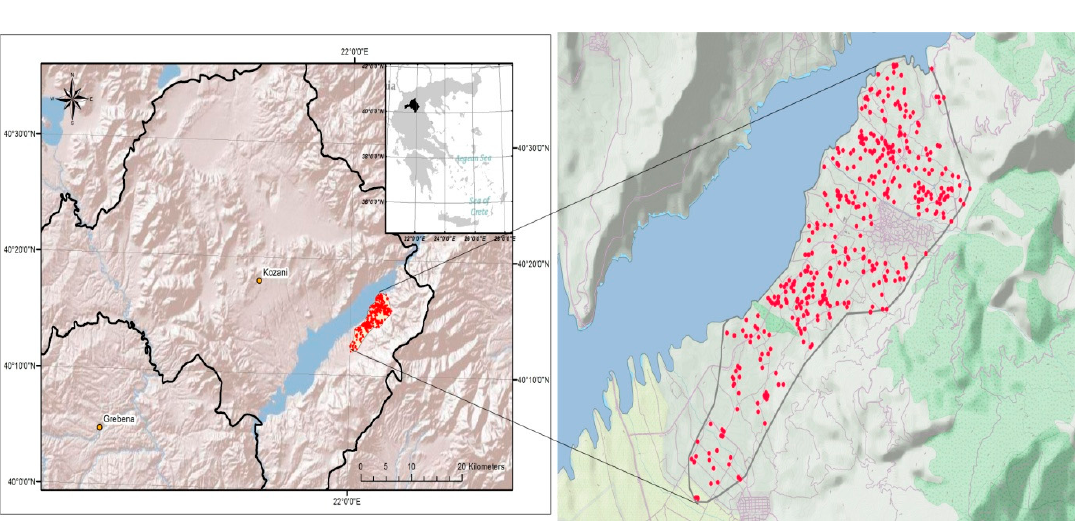
Figure 1. The 400 survey points in the Kozani area around Polifitou Lake in northern Greece.